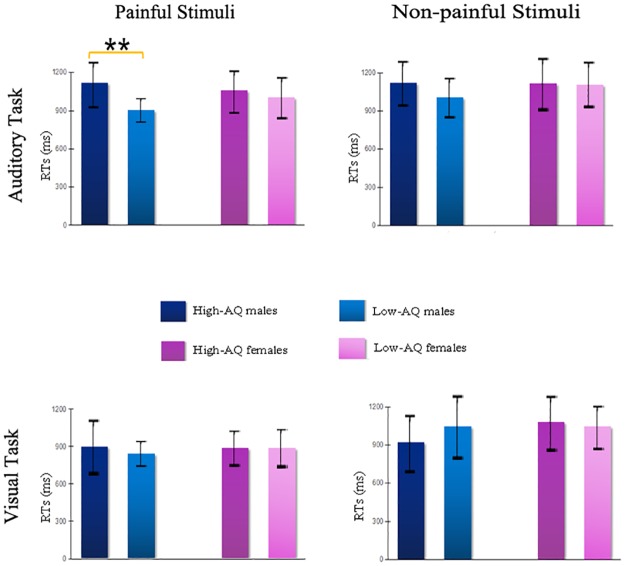
(Top) RTs for painful stimuli (left) and non-painful stimuli (right) in auditory tasks; (Bottom) RTs for painful stimuli (left) and non-painful stimuli (right) in visual tasks.Data are presented as mean values (more details see S1 Table). Error bars represent standard error of the mean. Significant effect at p< 0.01 is marked by two asterisks.